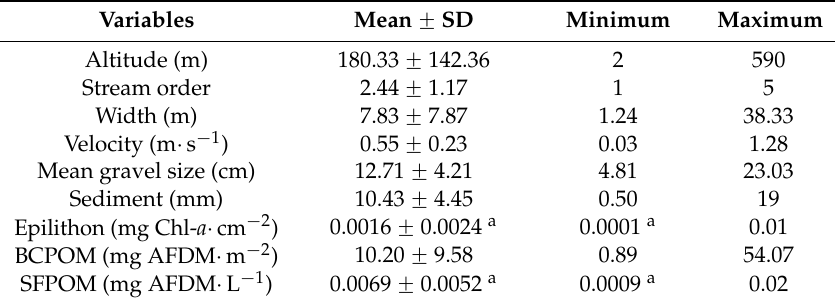
Table 1. Summary of natural environmental variables measured at sampling sites ( n = 57) during the survey period. When precise values were measured the higher number of significant digits are listed with the symbol “ a